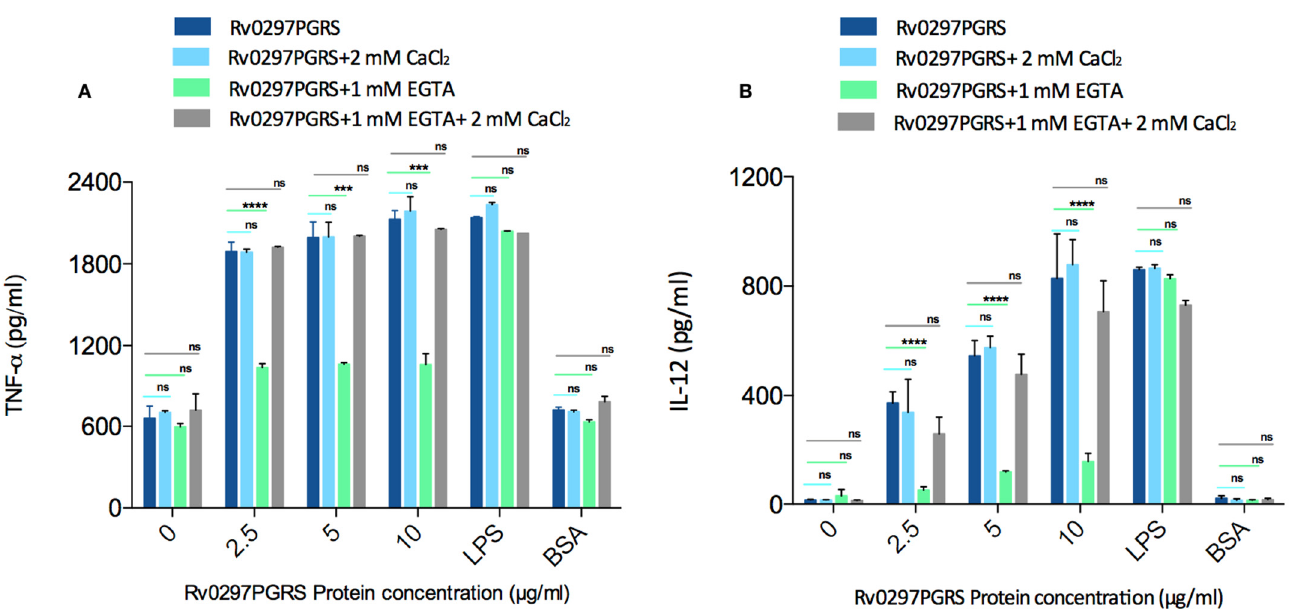
Figure 7. Rv0297 PGRS induces cytokine production in calcium-dependent manner. Calcium supported rRv0297 PGRS induced TNF- α ( A ) and IL-12 ( B ) production in THP-1 macrophages. Normal cell culture medium (DMEM) consists of calcium chloride salt. Calcium free environment was achieved using 1 mM EGTA in the culture medium. Replenishment of Ca 2+ ions was done by using 2mM CaCl 2 along with 1mM EGTA in the experimental medium to overcome the effect of EGTA. A range of Rv0297PGRS protein was used to stimulate THP-1 macrophages under different types of experimental conditions mentioned above. Data were plotted as cytokine concentration in pg/mL. All of the values were represented as means ± SDs from three independent experiments. p values for *, **, ***, and ns are <0.05, <0.01, <0.001, and >0.05, respec- tively.